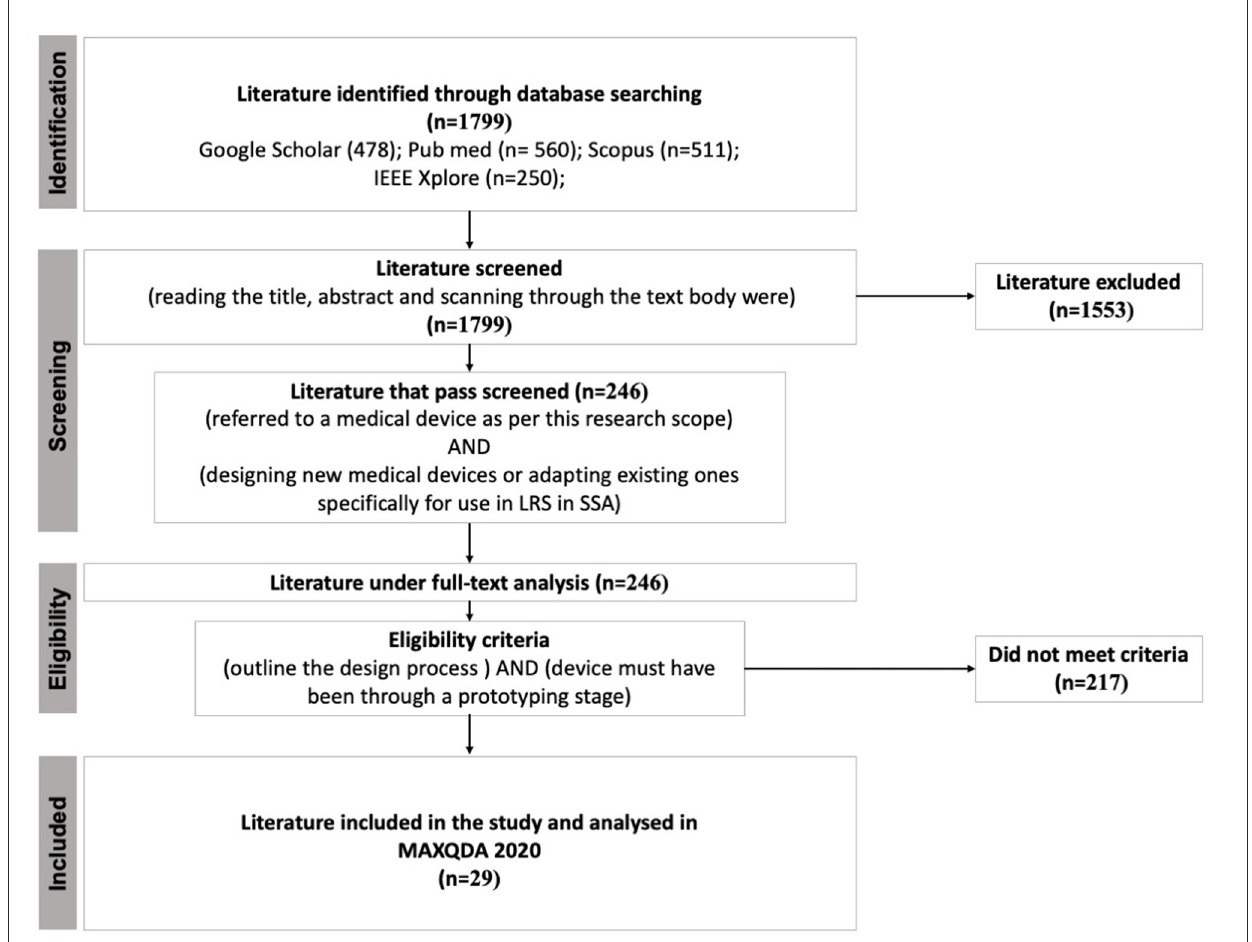
FIGURE2 Summary of the systematic review process. Acronyms LRS and SSA are low-resource settings and Sub-Saharan Africa,